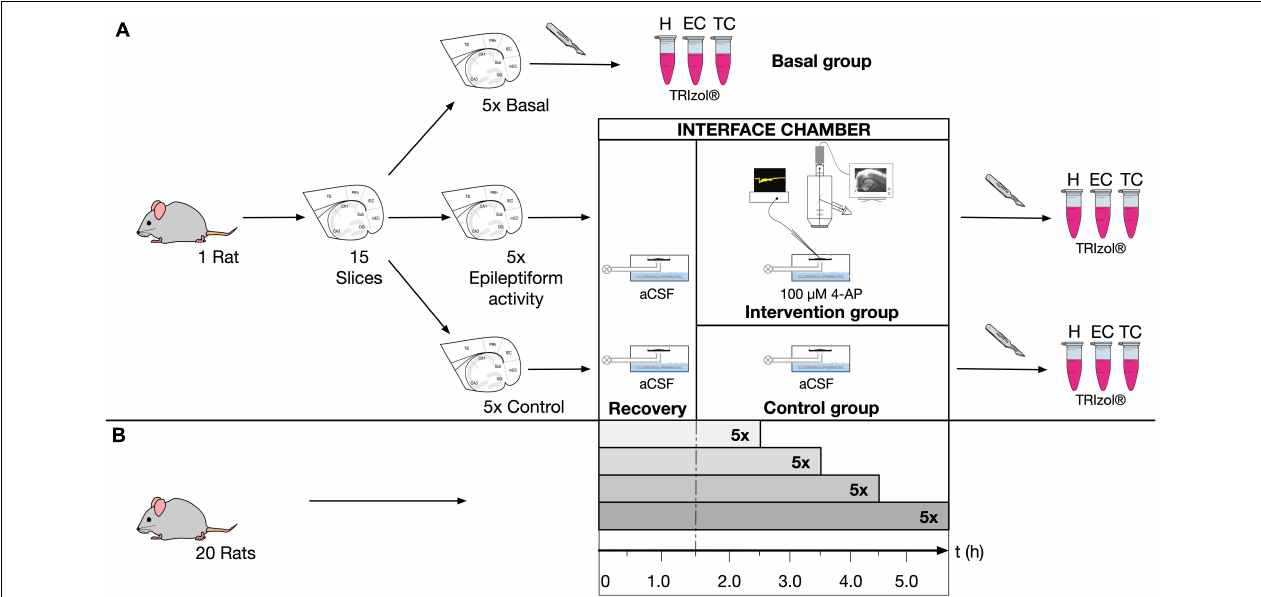
FIGURE 1 | Study design for rat tissue. (A) Chronological sequence of each experiment: rat brain preparation; allocation of 15 horizontal slices to three different groups (basal, control and intervention); recovery of 10 slices (control and intervention group) for 1.5 h in an interface chamber with incubation in carbogenated aCSF (95% O 2 , 5% CO 2 , pH 7.4); induction of epileptiform activity by 100 µ M 4-AP in five slices (intervention group) and recording of field potentials as well as intrinsic optical signals; five control slices in aCSF for same amount of time; microdissection of slices into hippocampus (H), entorhinal cortex (EC), and temporal cortex (TC) and subsequent cell lysis of pooled tissue in TRIzol before RT-qPCR. (B) Procedure was performed with 20 rats in total; five rats were assigned to each 4-AP treatment duration of 1, 2, 3, or 4